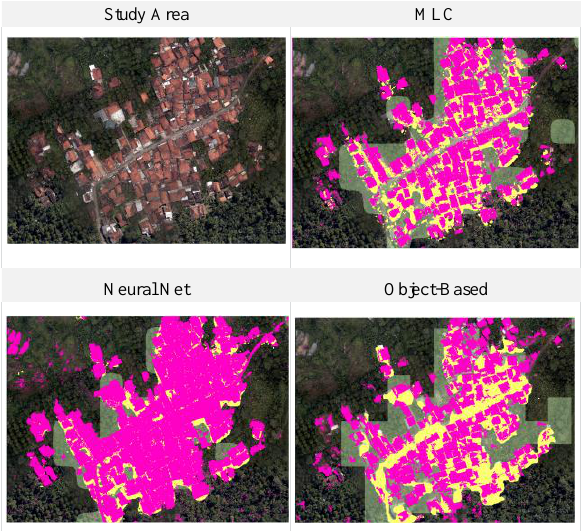
Figure 6. Pattern consistency for settlement feature